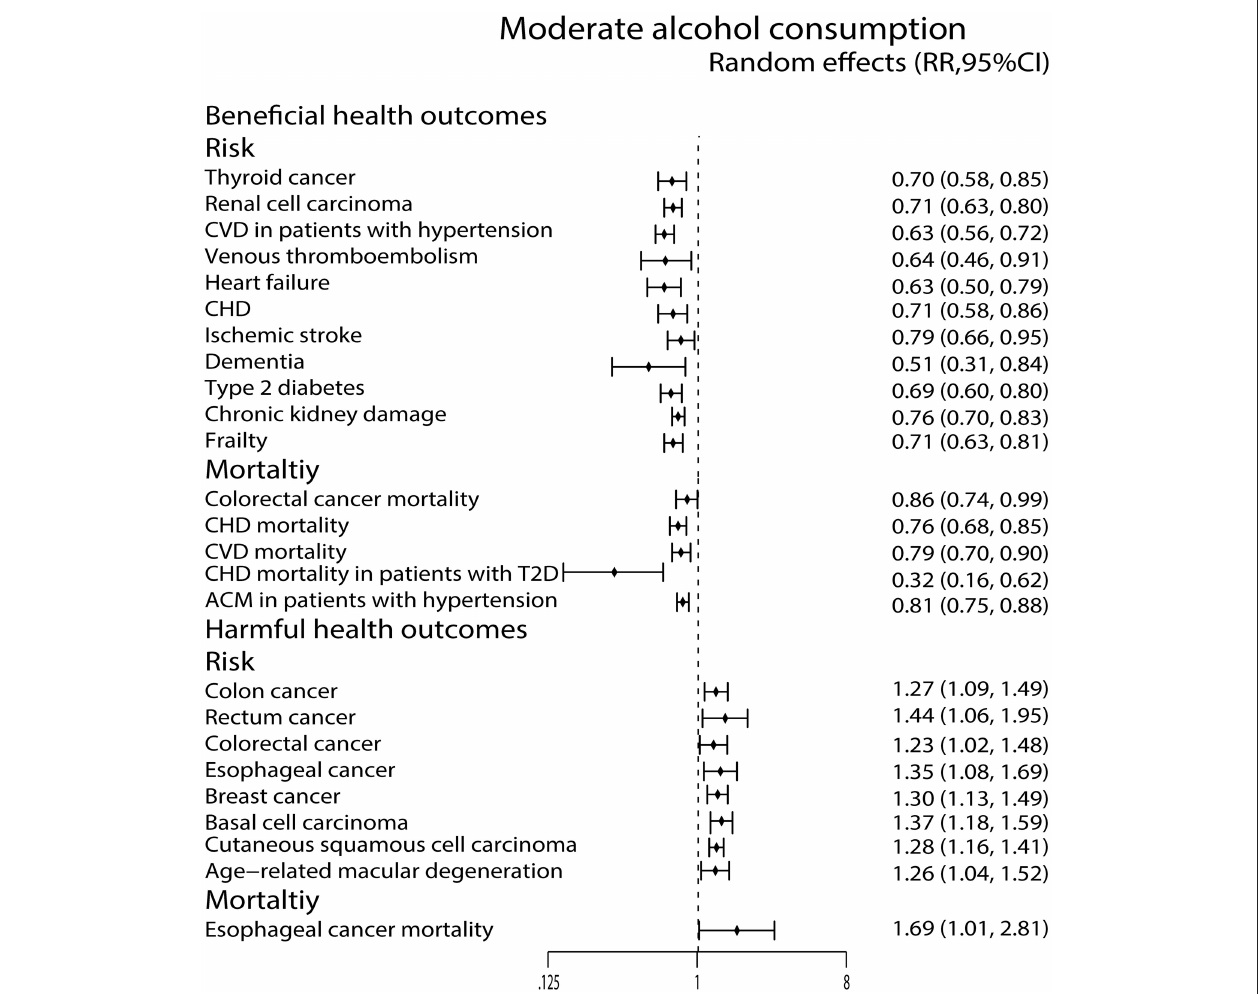
FIGURE 4 | Forest plot: recalculated effects estimates of meta-analyses reporting significant associations of moderate alcohol consumption with health outcomes. RR, relative risk; CI, confidence interval; CHD, coronary heart disease; CVD, cardiovascular disease; ACM, all-cause mortality.